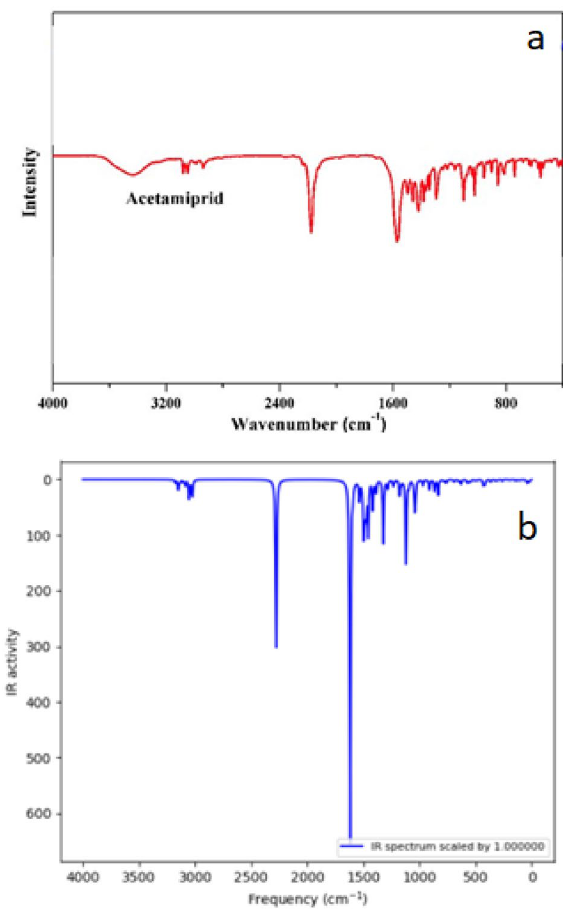
Figure 8. Experimental ( a ) and theoretical ( b ) acetamiprid IR